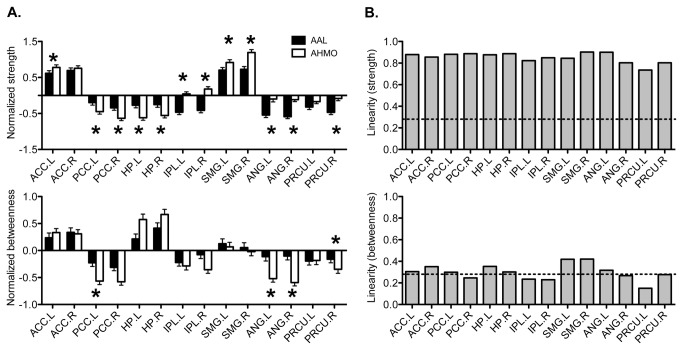
Nodal properties of regions within regions associated with the default mode network.(A) Comparisons of normalized strength and betweenness centrality between AAL and AHMO. Star (*) represents significant difference (P<0.05, Bonferroni corrected for all comparisons). (B) Linearity of strength and betweenness centrality between AAL and AHMO. Dotted line (---) represents significant correlation (R=0.28; P<0.05, Bonferroni corrected for all comparisons). ACC.L: the left anterior cingulate cortex, ACC.R: the right anterior cingulate cortex, PCC.L: the left posterior cingulate cortex, PCC.R: the right posterior cingulate cortex, HP.L: the left hippocampus, HP.R: the right hippocampus, IPL.L: the left inferior parietal lobule, IPL.R: the right inferior parietal lobule, SMG.L: the left supramarginal gyrus, SMG.R: the right supramarginal gyrus, ANG.L: the left angular gyrus, ANG.R: the right angular gyrus, PRCU.L: the left precuneus, PRCU.R: the right precuneus.